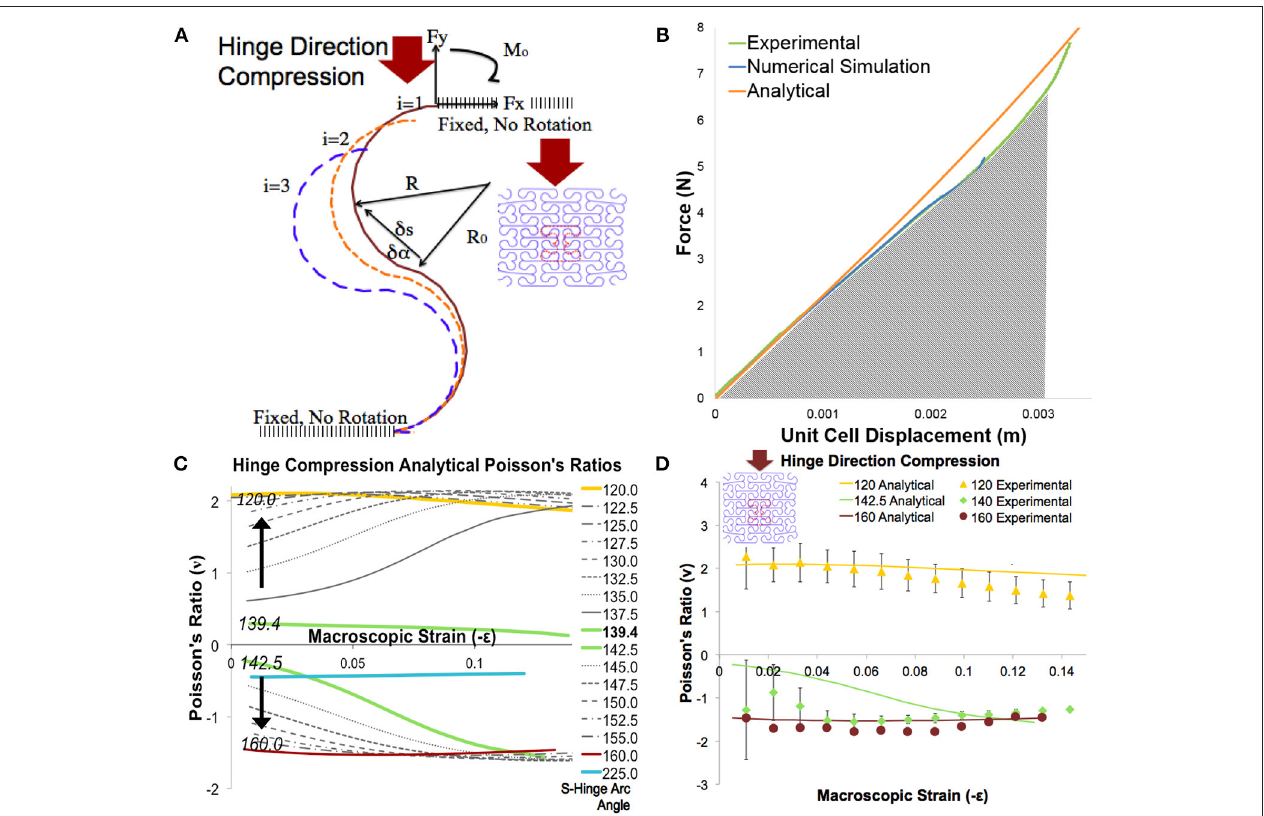
FIGURE 4 | Analytical and experimental Poisson’s ratios. (A) Schematic from the mathematical model that demonstrates variables involved in calculation of the bending movement. (B) The semi-analytical model is in good agreement with the experimental results and numerical simulation when the 225-degree deformed in the hinge direction. (C) Poisson’s ratio is sensitive to the change in arc-angle near the critical arc angle of 139.4 degrees. 225-degree Poisson’s ratio also displayed (blue line). (D) Poisson’s ratio can be tuned by changing the s-hinge arc angle. Experimental Poisson’s ratios (data points) are compared to Poisson’s ratios computed analytically (solid lines) when compressed along the hinge